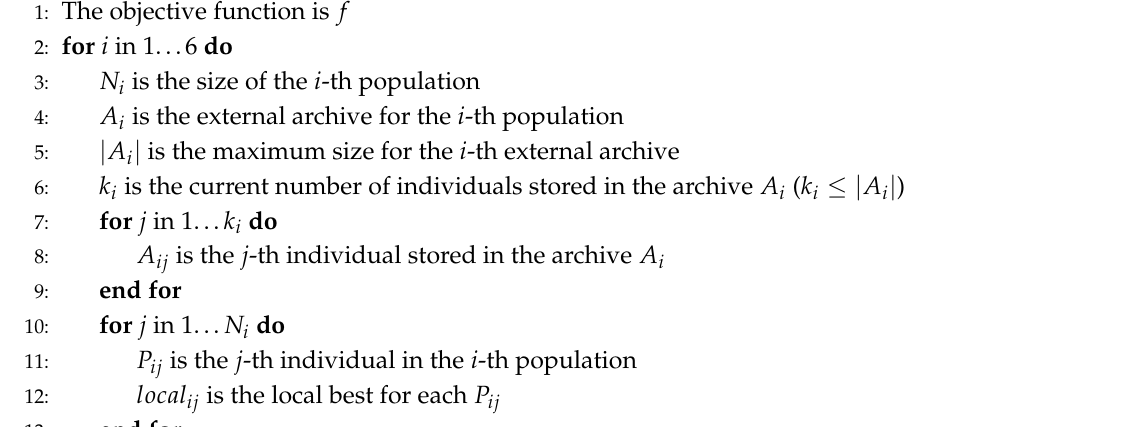
Algorithm 1 The process of updating the external archive for component